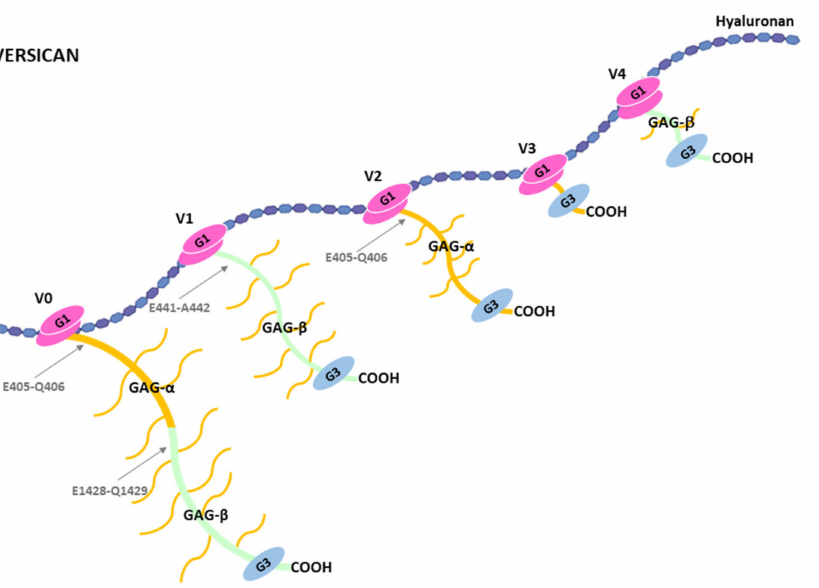
Figure 4. Schematic representation of the different isoforms of versican V0, V1, V2, V3 and V4. GAG- α and GAG- β are the two different glycosaminoglycans binding sites between the G1 and G3 globular domains. Arrows indicate some cleavage sites in versican. E405-Q406 is cleavage site in the GAG- α both in versican V0 and V2. E1428-Q1429 in versican V0 is the equivalent to E441-A442 in human versican V1 (see reference